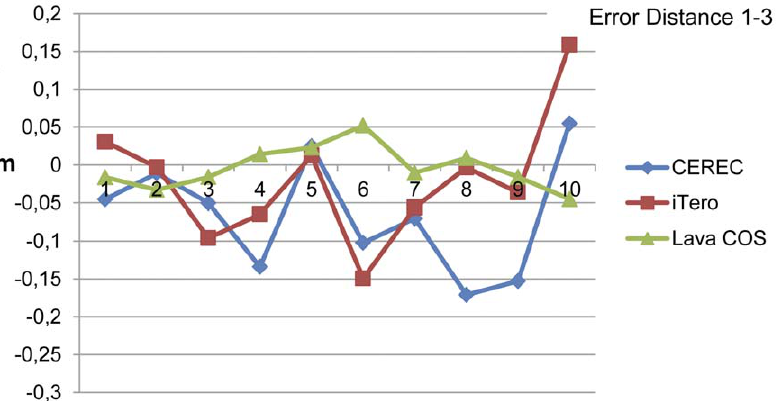
Figure 7. The distance errors between the cylinders 1 and 3 in millimeters for the three intra-oral scanners. The smallest distance error between cylinders 1 and 3 was 2 32,0 m m (iTero), while the largest error was 2 171,1 m m (CEREC). The Lava COS scanner showed the smallest mean distance error and also showed the smallest variations.